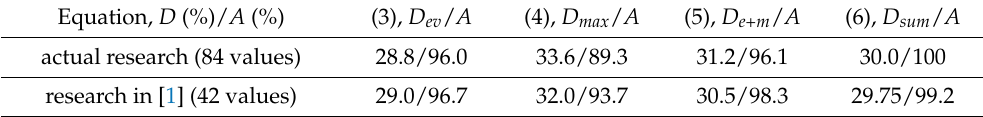
Table 2. Final average admixing rates D and accuracies A calculated with different equations. Equation, D (%)/ A (%) (3), D ev /